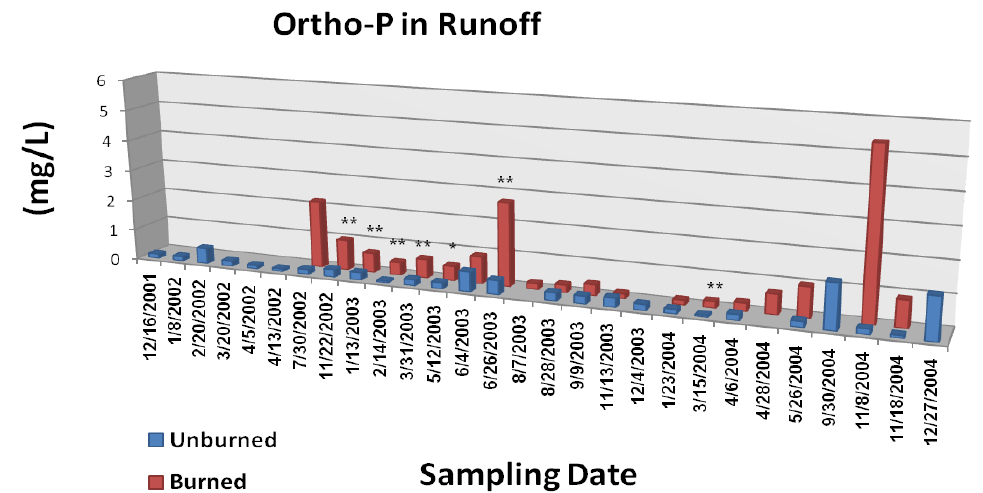
Figure 6C. Mean ortho-phosphate P concentrations in overland/litter interflow runoff from unburned and wildfire burned study plots. The Gondola wildfire occurred July 3, 2002. Significant differences are noted as p < 0.10 (*), p < 0.05 (**), or p < 0.01 (***). Adapted from